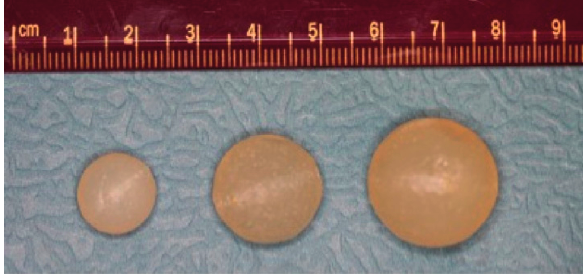
Figure 1. Spherical semi-soft vaginal suppositories, 1, 3, 5 mL (left to